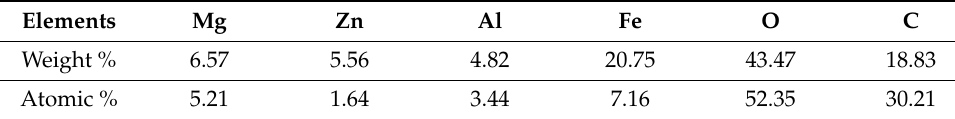
Figure 2. SEM images ( a , b ) and EDX analysis ( c ) of the MZFA. Table 1. The results of EDX analysis.